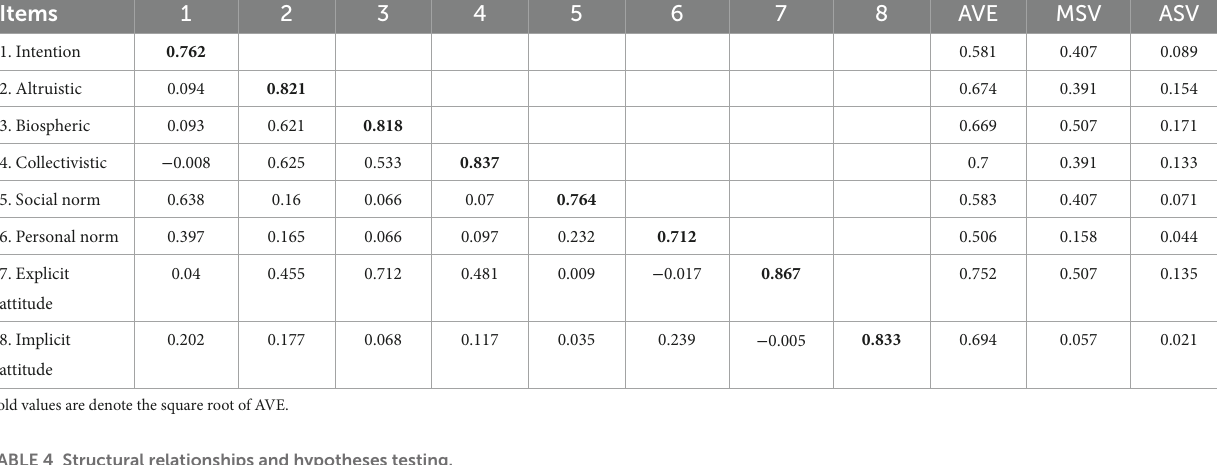
TABLE 4 Structural relationships and hypotheses